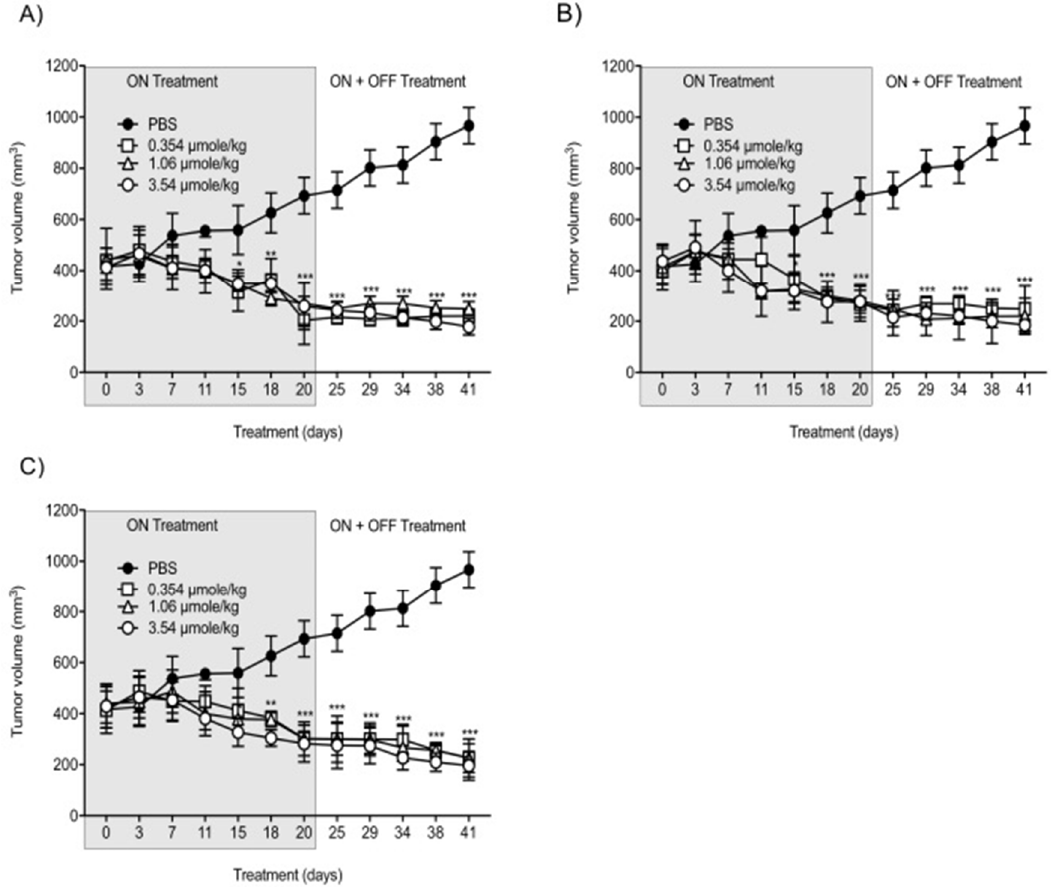
Figure 6. Anti-cancer effects of Compounds 1 , 2 , and 3 on tumor volumes. ( A ) Compound 1 ; ( B ) Compound 2 ; ( C ) Compound 3 . U87-luc glioblastoma cells implanted mice were treated daily with Compounds 1 , 2 , and 3 (ON Treatment) for 21 days, and in the second group, the xenografts were observed for an additional 21 days with no further treatment (ON Treatment + OFF Treatment). Values are presented as the mean tumor volume (mm 3 ) ± S.D. *** p < 0.001, ** p < 0.01, * p < 0.05, compared to the control.